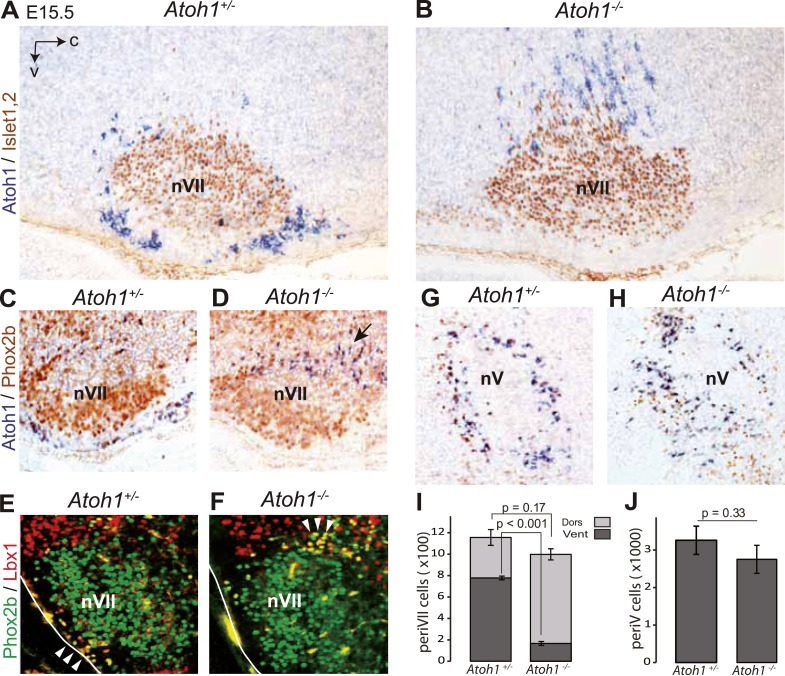
Ventral to dorsal shift of periVII and normal location of periV cells in Atoh1−/− embryos.(A and B) Combined in situ hybridization (ISH) with a 3′ UTR probe of Atoh1 (blue) and immunohistochemistry (IHC) with anti-Islet1,2 antibodies (brown) to visualize nVII on sagittal sections through the hindbrain from E15.5 Atoh1+/− and Atoh1−/− embryos. In Atoh1−/− embryos, the neurons identified by expression of the Atoh1 3′ UTR, which would have expressed Atoh1 protein normally, are depleted ventral of nVII visualized by Islet1,2 labeling, but accumulate dorsally. (C and D) Combined ISH with a 3′ UTR probe for Atoh1 and IHC for Phox2b on sagittal (C and D) (anterior at left) sections through the medulla of E15.5 Atoh1+/− and Atoh1−/− embryos as indicated. The arrow points to the dorsally shifted periVII cells that express the Atoh1 3′ UTR and Phox2b. The PeriVII cells that would have normally expressed the Atoh1 protein are depleted ventral of nVII in the mutants and accumulate dorsally. (E and F) Immunofluorescence for Phox2b (green) and Lbx1 (red) on coronal sections (lateral at left) through the medulla of E15.5 Atoh1+/− and Atoh1−/− embryos. The Lbx1+/Phox2b+ periVII cells (yellow) are depleted ventral of nVII but accumulate dorsally (arrowheads). (G and H) Combined ISH with a 3′ UTR probe for Atoh1 and IHC for Phox2b on coronal sections (lateral at left) through the pons of E15.5 Atoh1+/− and Atoh1−/− embryos showing the normal location of periV cells in the mutants. (I) Quantification of the dorsal and ventral population of periVII cells identified by Atoh1 3′ UTR expression at E15.5. Their total numbers were not significantly different from the controls in Atoh1−/− embryos, but 83 ± 1.5% are located dorsally in the mutants vs 32 ± 4.1% in the controls. (J) Quantification of periV cells identified by Atoh1 3′ UTR expression at E15.5.